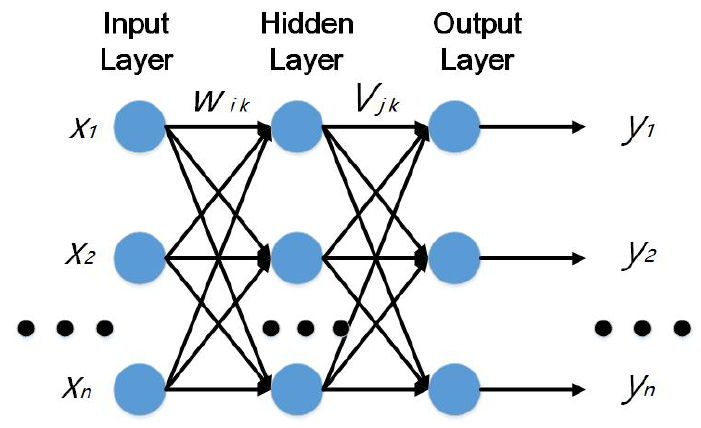
Figure 1. Back Propagation ( BP) neural network basic structure.